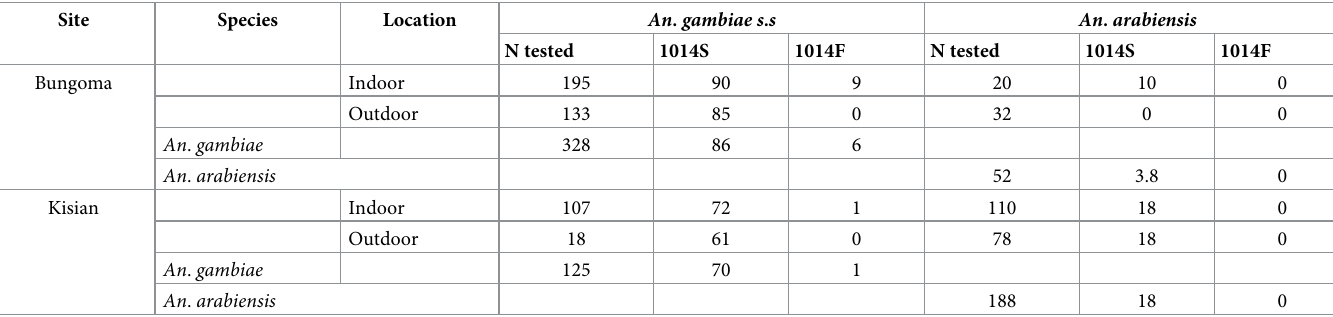
Table 1. Frequency of Kdr mutations in An . gambiae s . s and An . arabiensis populations of western Kenya. Site Species